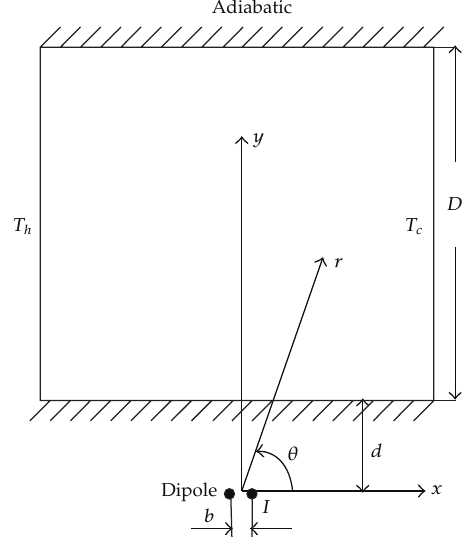
Figure 1: Schematic of the cavity and position of the line dipole